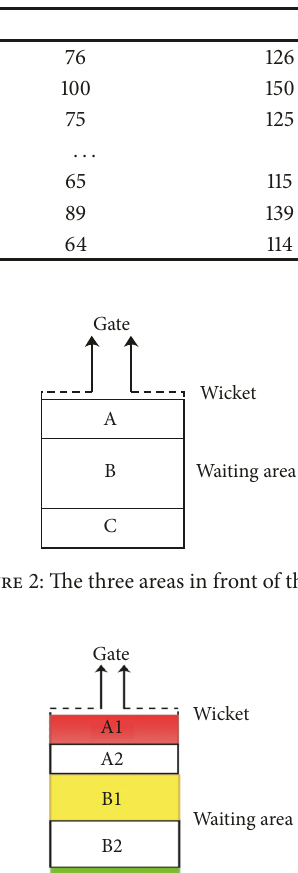
Table 4: The scheme of the Steffen strategy [7].